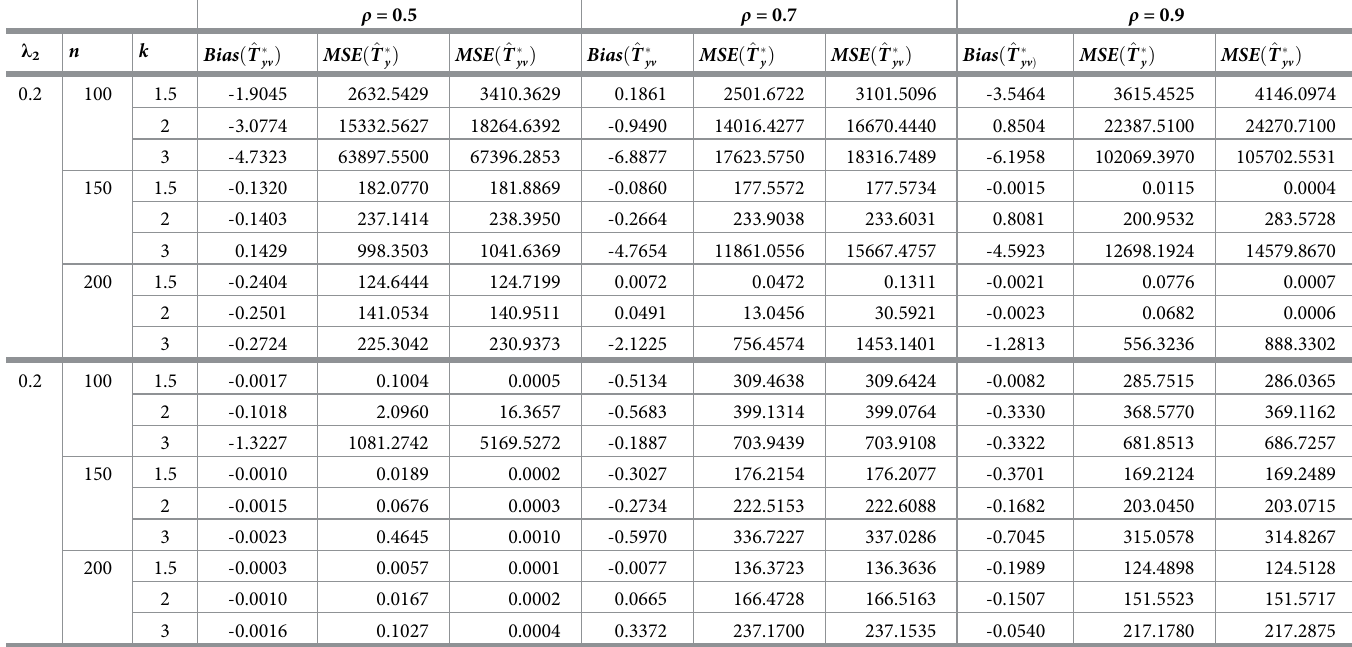
Table 2. Bias and MSEs with σ 2 = 0.01 and p = 8. ρ = 0.5 ρ = 0.7 ρ = 0.9